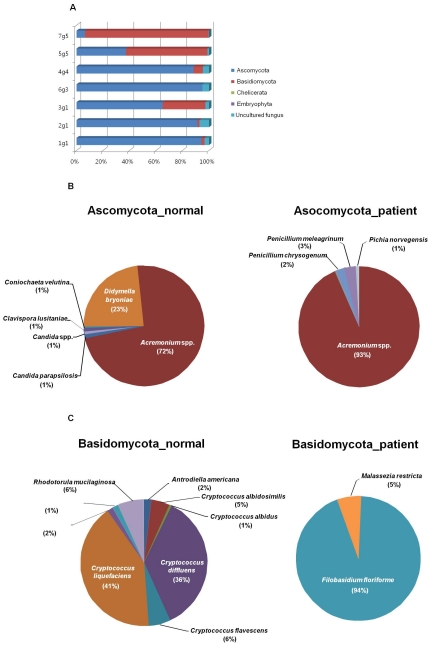
Diagram of mycobiome communities at the phylum level.(A) Distribution of mycobiomes between the normal scalps and the dandruff-afflicted scalps. (B) Distribution of genera belonging to the phylum Ascomycota in healthy and dandruff-afflicted scalps. (C) Distribution of genera belonging to the phylum Basidiomycota in healthy and dandruff-afflicted scalps.